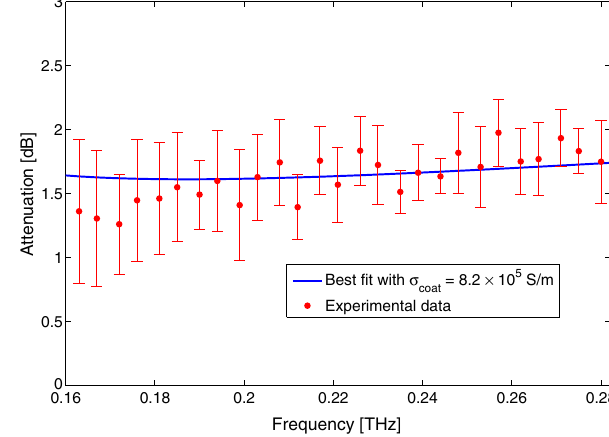
FIG. 13. Frequency spectrum showing the averaged amplitude data for the three samples: copper slab (red dots), NEG coated slab 3 . 96 μ m (blue dots) and NEG coated slab 3 . 68 μ m (green dots).